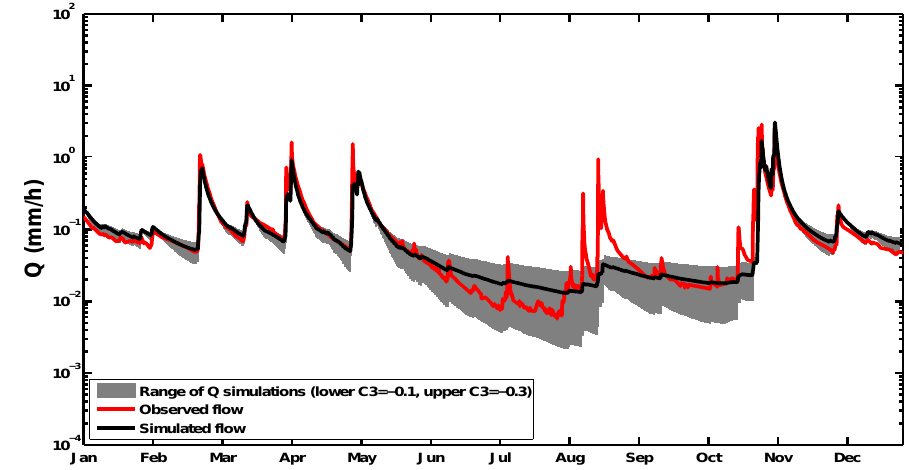
Figure 8. Observed versus simulated hydrograph ( C 3 = − 0 . 2) for the Ardèche at Meyras (#1) catchment (year 2004), with C 3 parameter variations ( C 1 and C 2 values are kept constant at ( − 3.74) and 0.65, respectively). The grey area shows the range of discharge simulations.